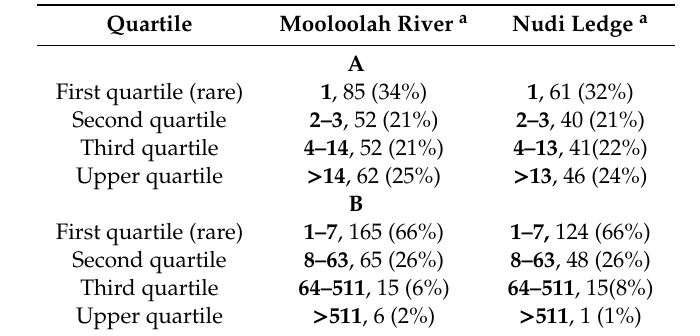
Table 1. Cut-o ff values (in quartiles—increments of 25%) for measures of numerical rarity, including number (percent) of species falling into each category for ( A ) the quartile method, and ( B ) the octave method based on log 2 bins. Percentages rounded to nearest whole number.